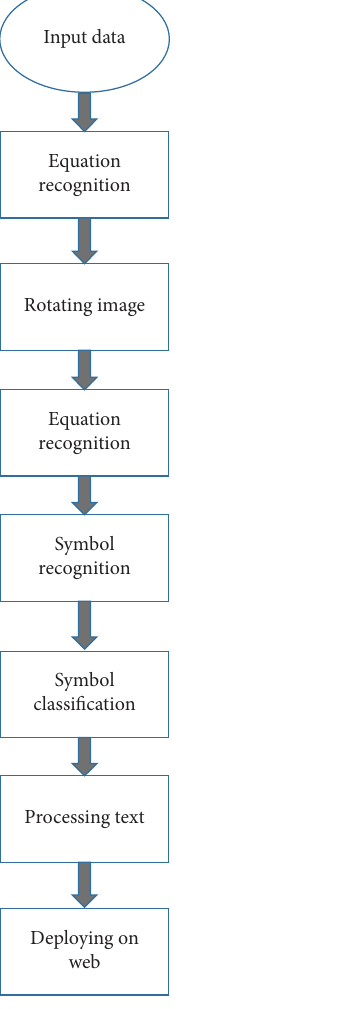
Figure 1: Diagram of the proposal